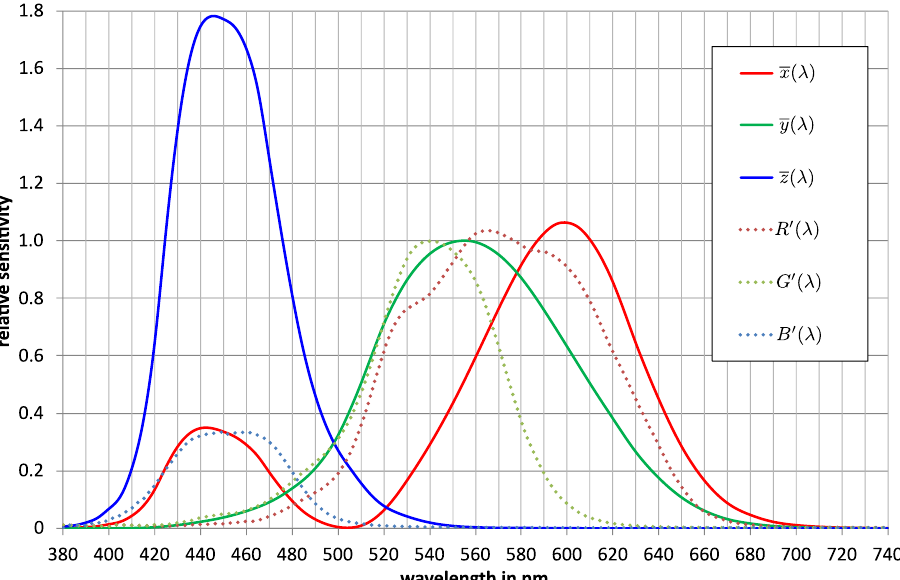
Figure 6. Corrected spectral sensitivity curves R (cid:48) ( λ ) , G (cid:48) ( λ ) , and B (cid:48) ( λ ) as a function of wavelength in comparison to the CIE 2° color matching functions x ( λ ) , y ( λ ) , and z ( λ )